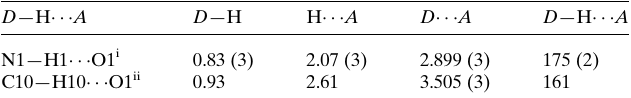
Table 2 Hydrogen-bond geometry (A˚ , (cid:3) ).